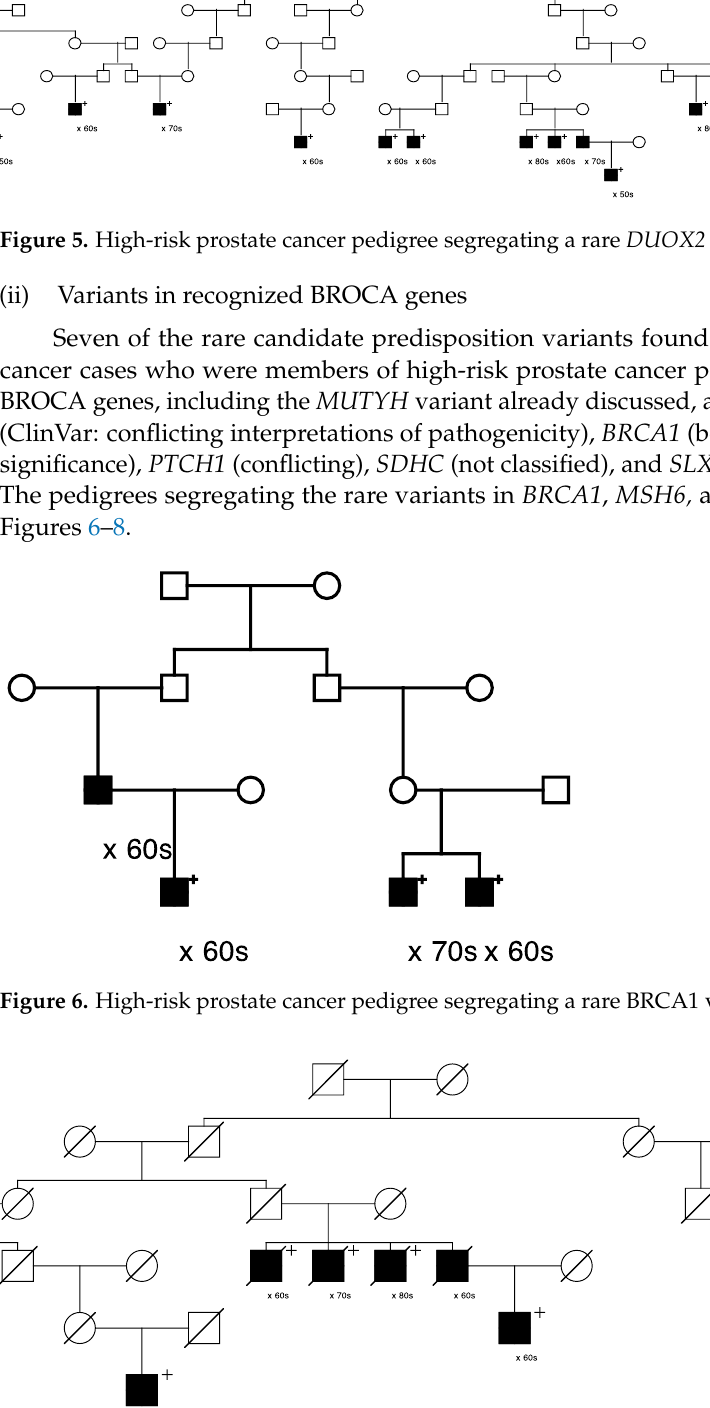
Figure 7. High-risk prostate cancer pedigree segregating a rare MSH6 variant.